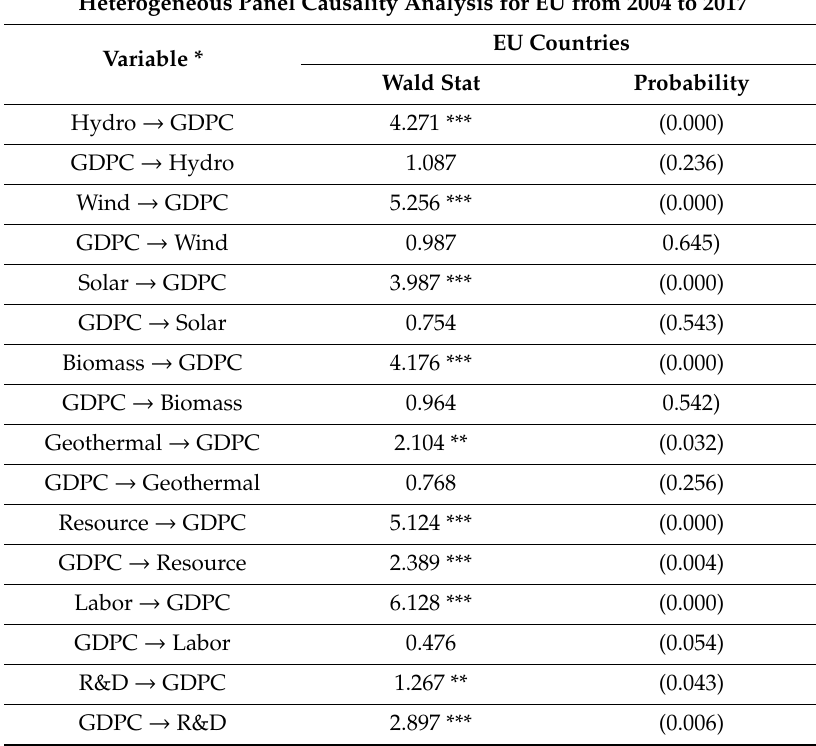
Table 8. Panel causality analysis summary for the EU region, from 2004 to 2017. Heterogeneous Panel Causality Analysis for EU from 2004 to 2017